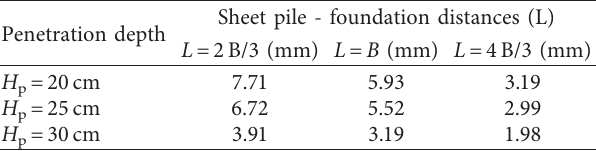
Table 8: Plaxis 3D input parameters of Sheet Pile.